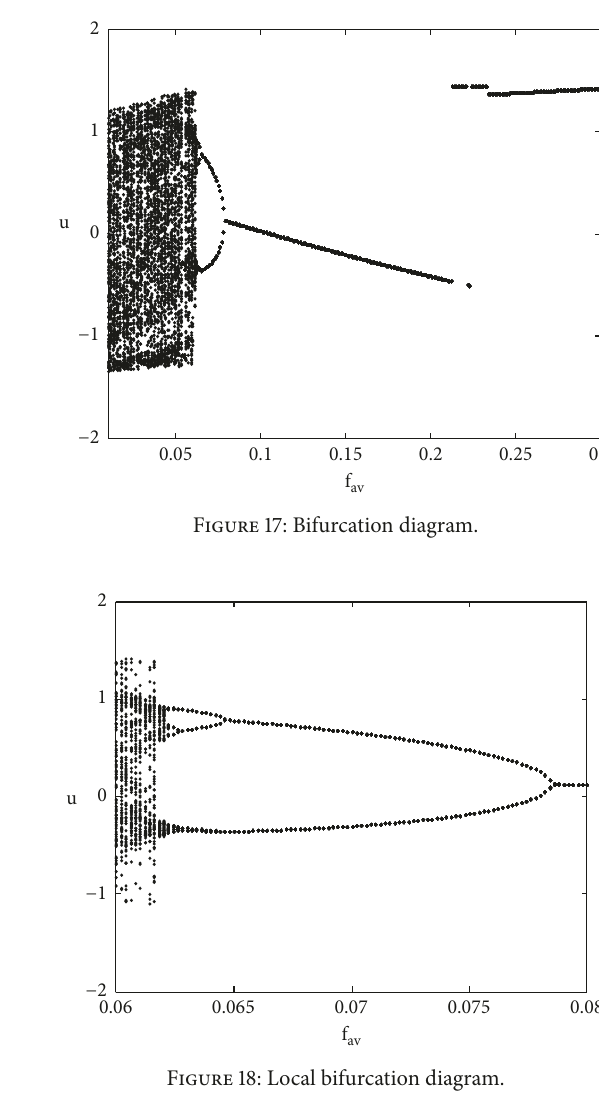
Figure 18: Local bifurcation